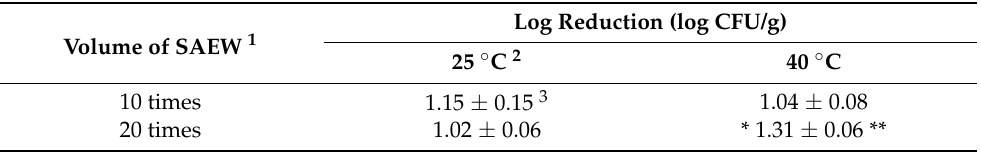
Table 2. Effects of volume and temperature on pathogenic E. coli (EPEC) population in fresh-cut carrot by combined treatment with SAEW and US for 3